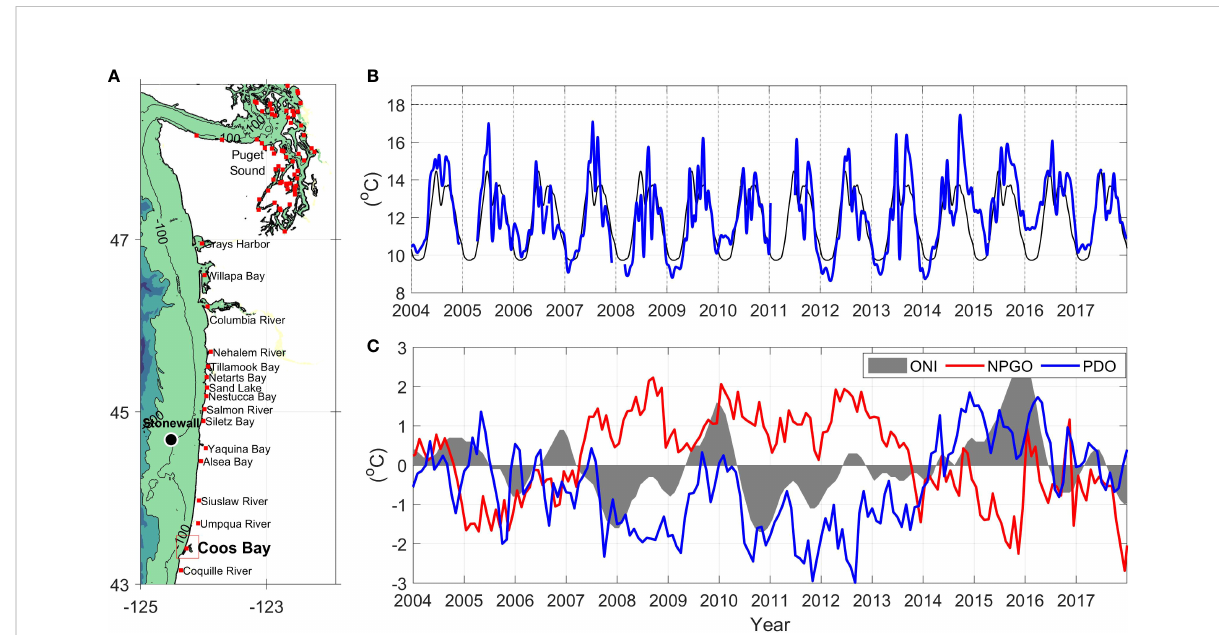
FIGURE 1 (A) Estuaries in the PNW where eelgrass ( Zostera marina) is present, including our study area (Coos Bay). The Stonewall buoy is also shown as a black circle. (B) Water temperature at the Stonewall buoy with the climatological mean calculated for 2004-2014 (black) and the daily averaged values with a 30-day low pass fi lter (blue). (C) Basin scale indices (water temperature anomaly): Oceanic Niño Index (ONI; gray area), North Paci fi c Gyre Oscillation (NPGO; red line), and Paci fi c Decadal Oscillation (PDO; blue